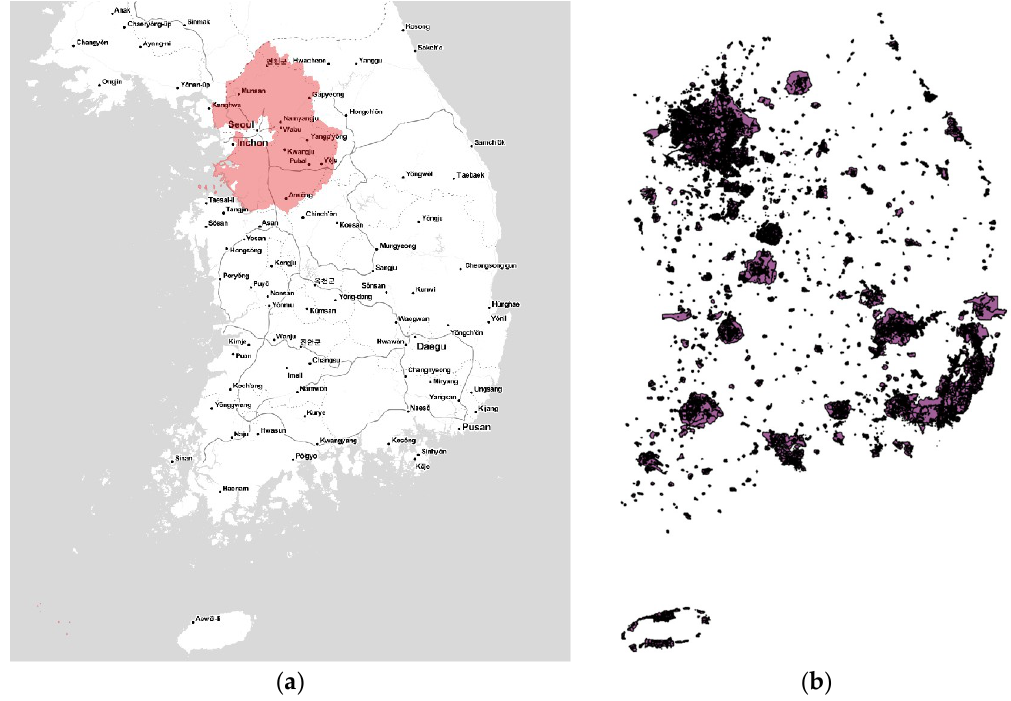
Figure 12. Visualization of two Tiger Files including real spatial datasets of Korea. ( a ) Part of the continuous cadastral map (1.24GB out of 16GB; 4,720,616 polygons out of 38,744,510 polygons) plotted using red and ( b ) major urban areas (0.3GB, 53,087 polygons) created for management of land use.